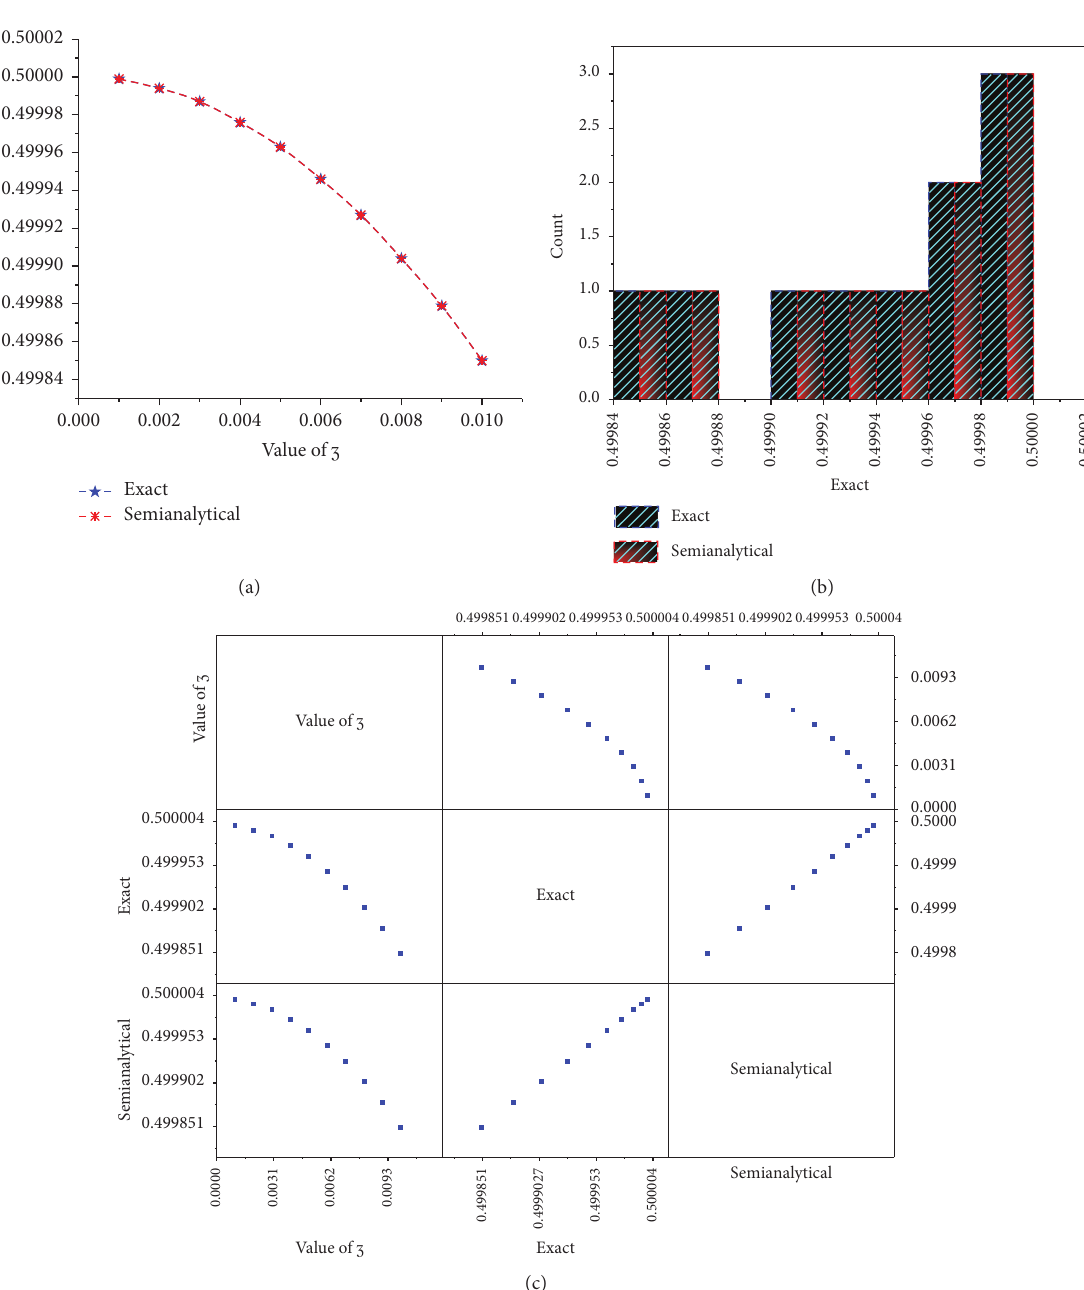
Figure 4: Exact and numerical solutions of equation (10) according to the obtained analytical solution via the sech-tanh expansion